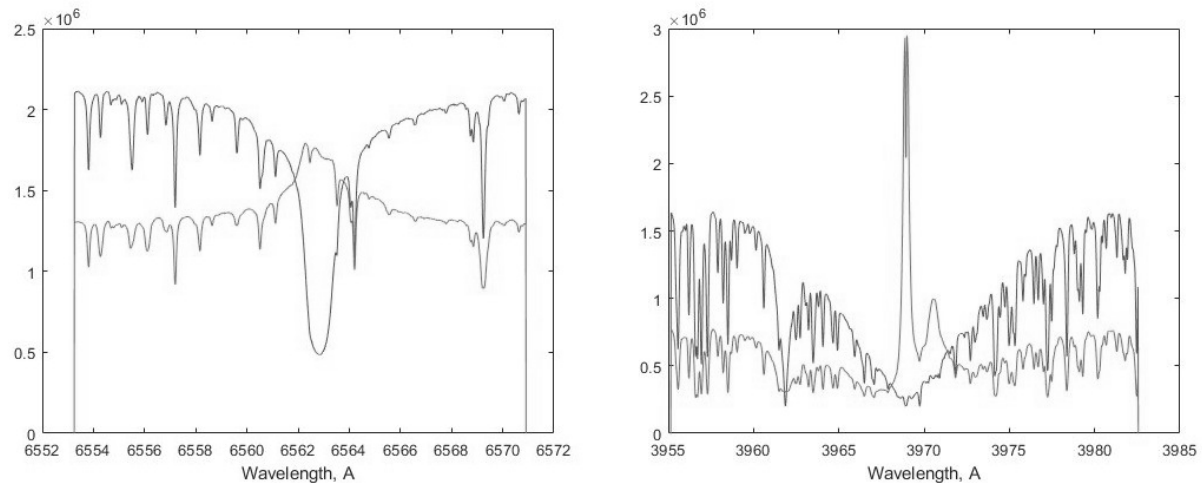
Figure 6. An example of calculating the integral flux F for lines H α and H CaII in solar flare. Emission profiles correspond to the flare region, absorption profiles – to the quiet Sun region. All intensities expressed in erg sr −1 cm −2 s −1 Å −1 units. Flux F in H α – 1.79 · 10 8 erg cm −2 s −1 ; F in H CaII – 2.43 · 10 8 erg cm −2 s −1 . The integration was carried out over the ranges: H α – 6561.88–6563.79 Å, H CaII – 3968.09–3971.36 Å.